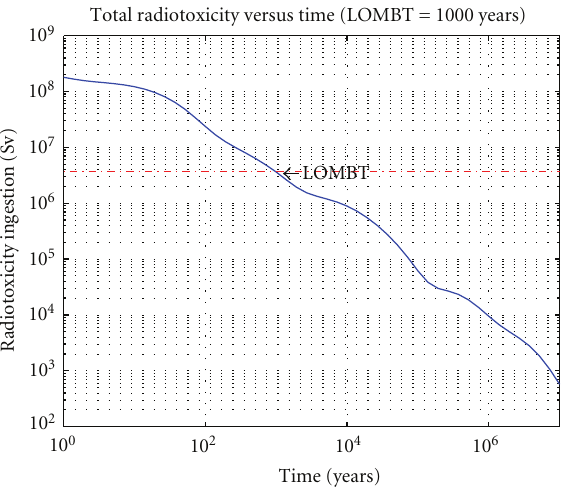
Figure 10: LOMBT of PBMR SNF (FPs, Am, and